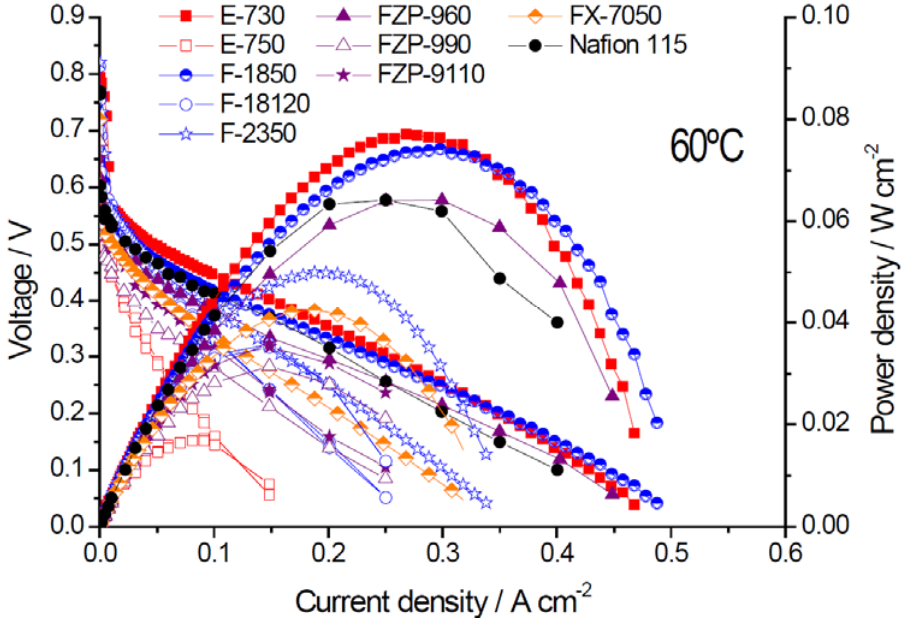
Figure 2. Polarization and power density curves for different membranes in MEAs at 60 °C, 2 M